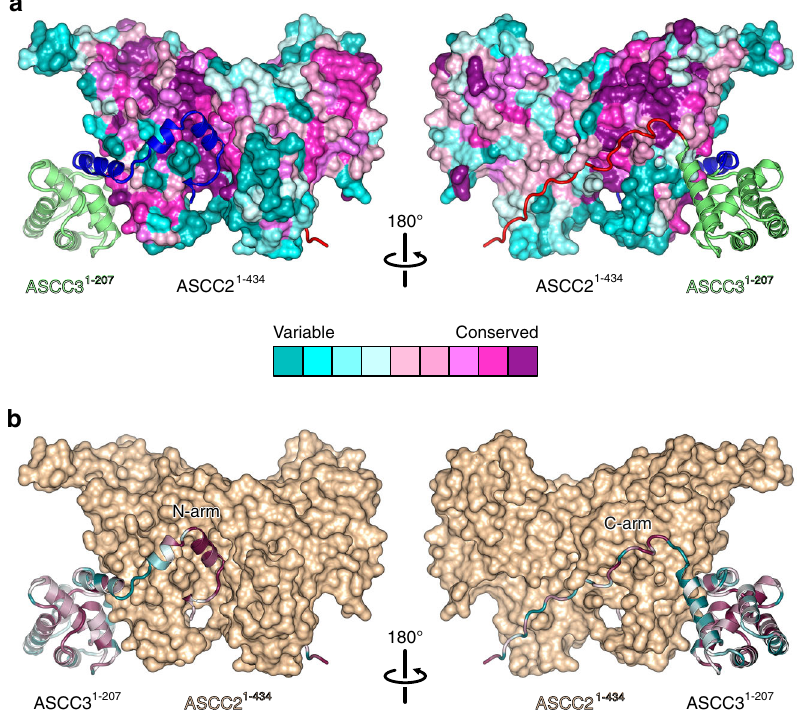
Fig. 2 Conservation of interfaces. a Residue conservation mapped to the surface of ASCC2 1 – 434 with ASCC3 1 – 207 shown as cartoon (colored as in Fig. 1f). b Residue conservation mapped on the structure of ASCC3 1 – 207 shown as cartoon, with ASCC2 1 – 434 in surface view (beige). Central legend, color code representing the degree of conservation of individual residues. Views as in Fig. 1d,